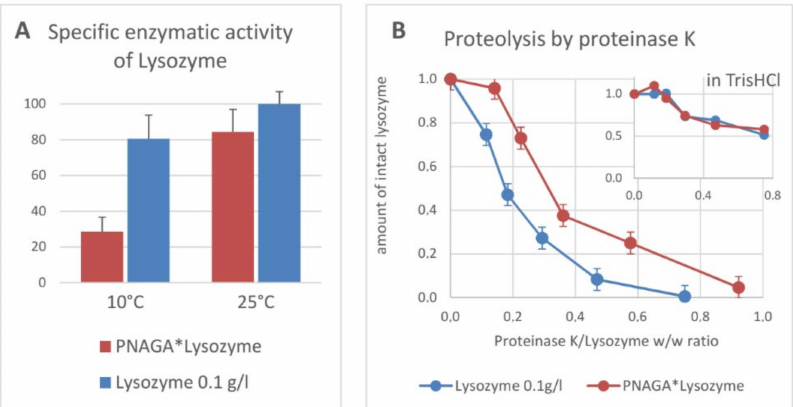
Figure 4. ( A ) Specific enzymatic activity of lysozyme in a free form and complexed with PNAGA. ( B ) Proteolytic digestion of lysozyme by proteinase K. Amount of intact lysozyme determined from SDS-PAGE bands intensity versus protease/lysozyme w / w ratio; red and blue line for complexes and free lysozyme, respectively. Here, 10 mM phosphate buffer, pH 7.4, +4 ◦ C. Inset represents control experiments in 50 mM TrisHCl buffer, pH